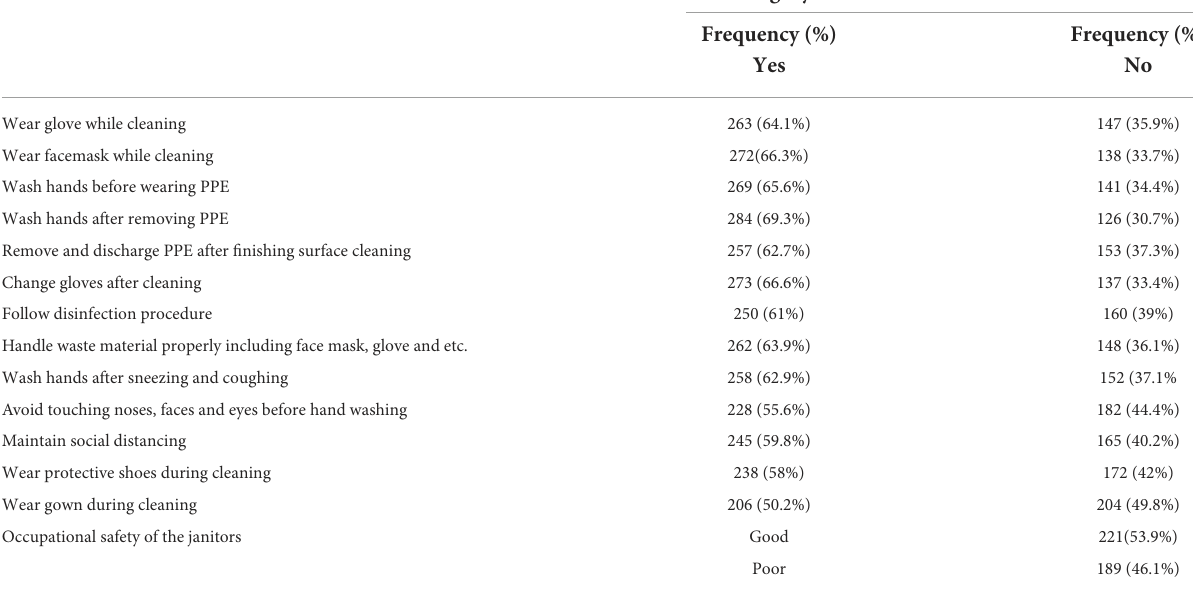
TABLE 4 Safe working practice of the Bule Hora University janitors to prevent COVID-19 transmission from November to December 2021.